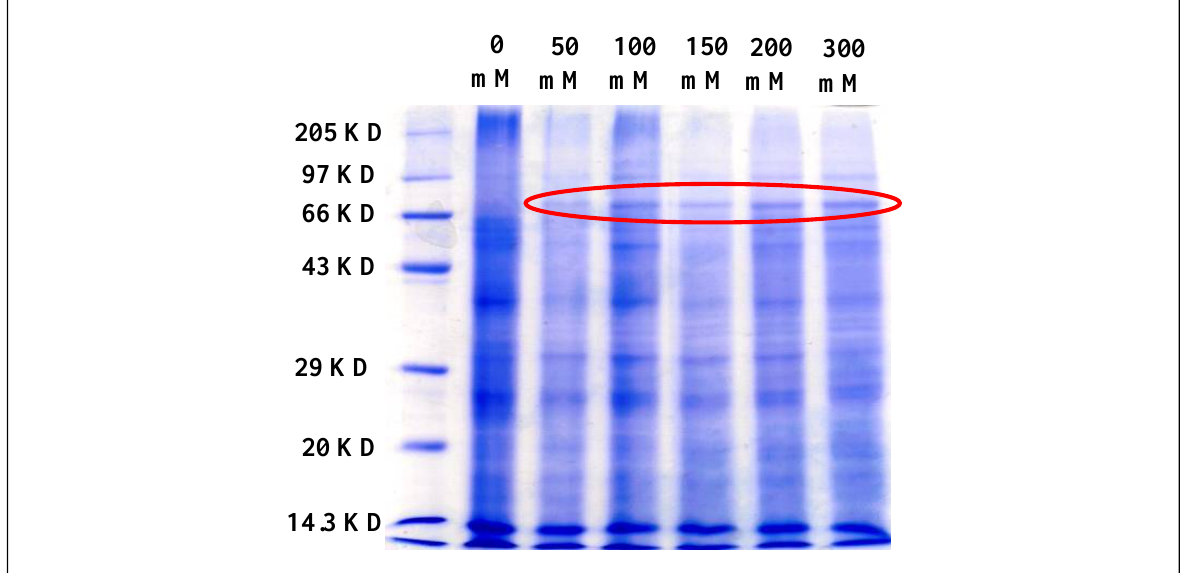
Figure 2: Effect of salt stress imposed by using NaCl on protein profile in excised etiolated maize leaf segments during greening